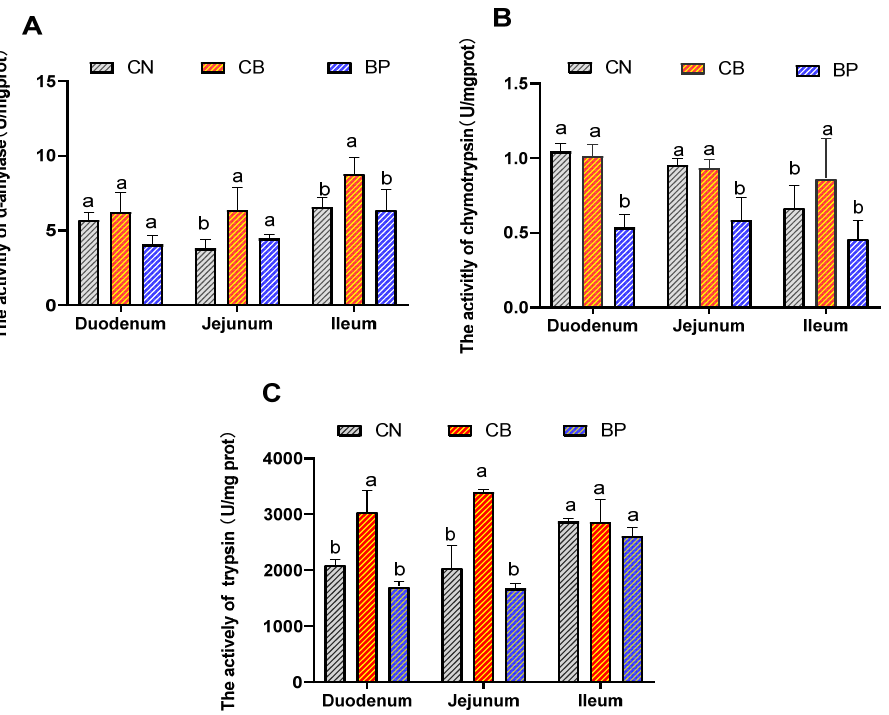
Figure 2. Effects of CN, CB, and BP on digestive enzyme activity in weaning rabbits. ( A – C ) α -amylase, chymotrypsin, and trypsin activity in small intestinal contents. CN, rabbits were fed a basal diet; CB, rabbits were fed a basal diet supplemented with Clostridium butyricum ; BP, rabbits were fed a basal diet supplemented with a bacteriophage cocktail (values are expressed as the mean ± SE, n = 8; a,b Mean values within a row with unlike superscript letters were significantly different ( p < 0.05).